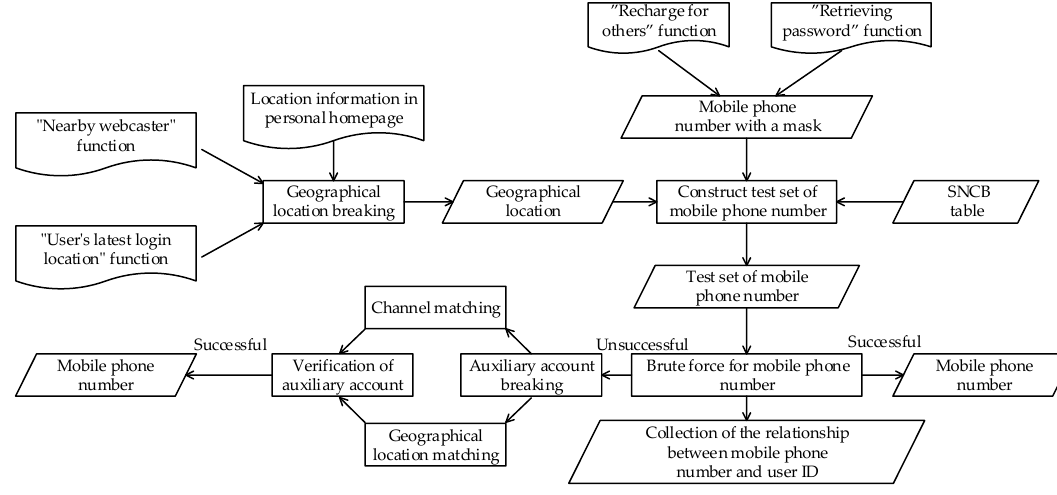
Figure 9. Overall process of breaking a YY user’s mobile phone number.